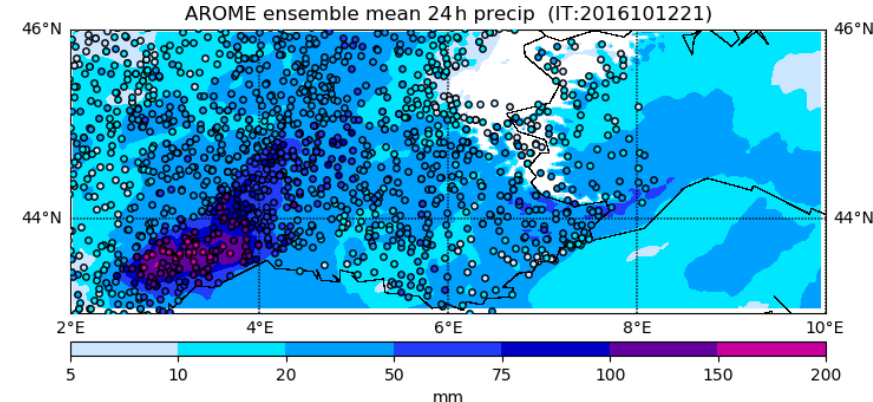
Figure 9. Observed (circles) and forecast (initialized 12 October 21:00UTC) ensemble mean accumulated daily precipitation until 14 Octo- ber 2016 06:00UTC.